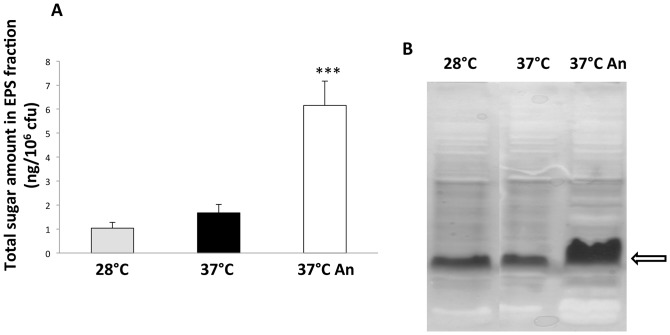
EPS/LPS determination.
A) Quantitative determination of cell surface-associated polysaccharides using the phenol/sulfuric acid method. Values are the average of six measurements (two repeats for three independent cultures) and standard deviations are shown. Statistical analysis (two-tailed Student’s t test) of the results provided a p value<0.0001 (indicated by the three asterisks in the figure). B) PAGE analysis of cell surface-associated polysaccharides. The main band detected by silver staining, is indicated by the arrow. PAGE analysis of cell surface-associated polysaccharides from three independent BtCDC272 cultures gave very similar results.